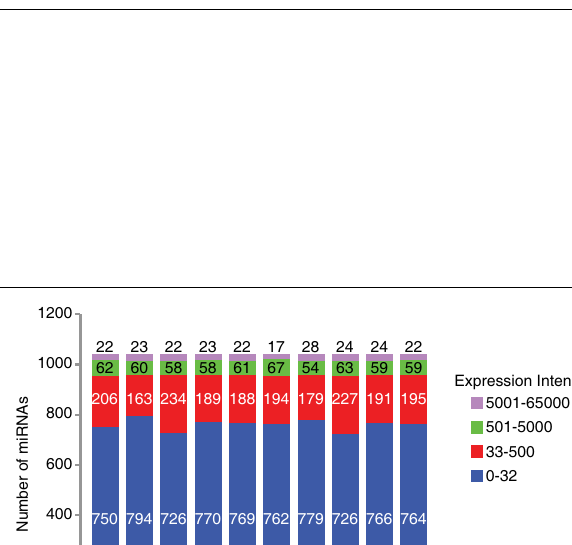
FIGUREA1 |Array profiling of miRNAs in REST cKO NSCs. Whisker box plot analysis demonstrated there was no significant global expression differences among the GFP and Cre-GFP groups regardless of proliferation versus differentiation conditions.